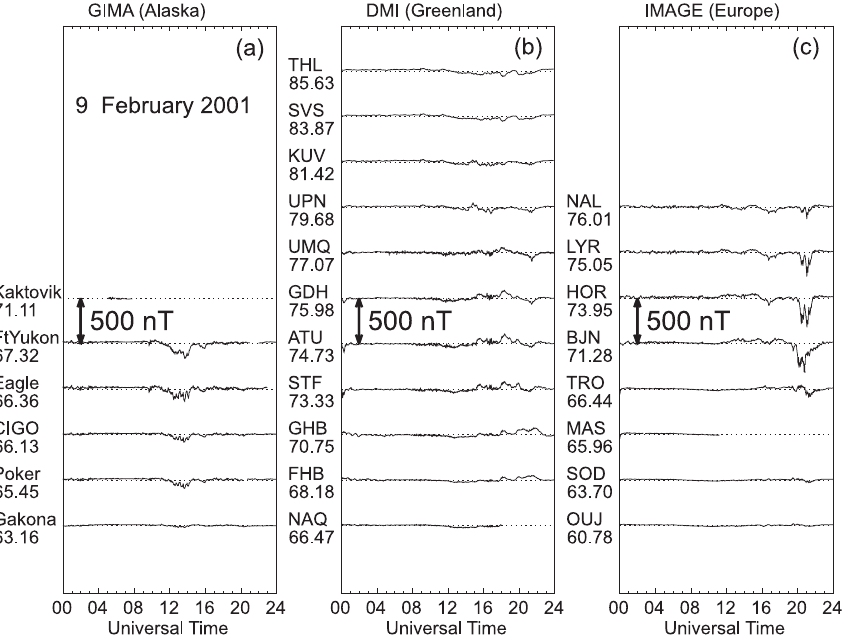
Fig. 3. Stackplots of North-South magnetic field component perturbations for 9 February 2001 in (a) Alaskan, (b) Greenland, and (c) European sectors. The names of magnetometer stations and respective AACGM latitudes are given on the left hand side of each